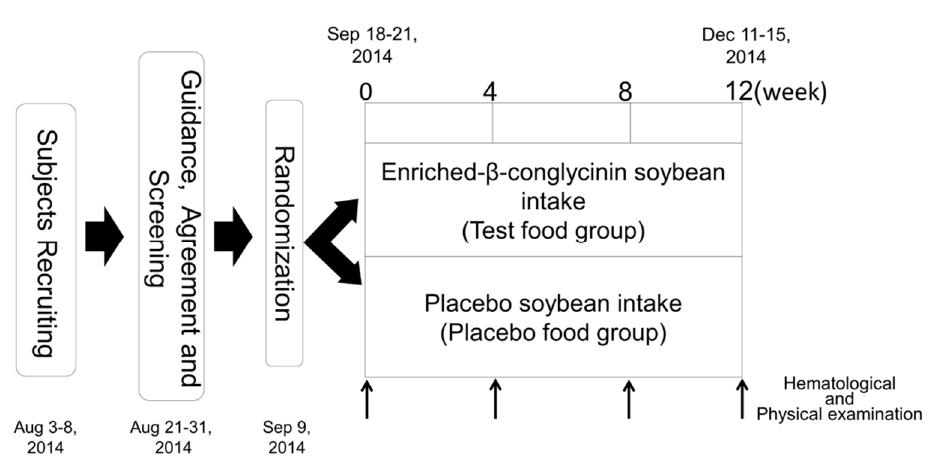
Figure 1. Time schedule (in weeks) for this clinical study. Hematological and physical examinations were conducted at baseline (week 0), and at weeks 4, 8, and 12.